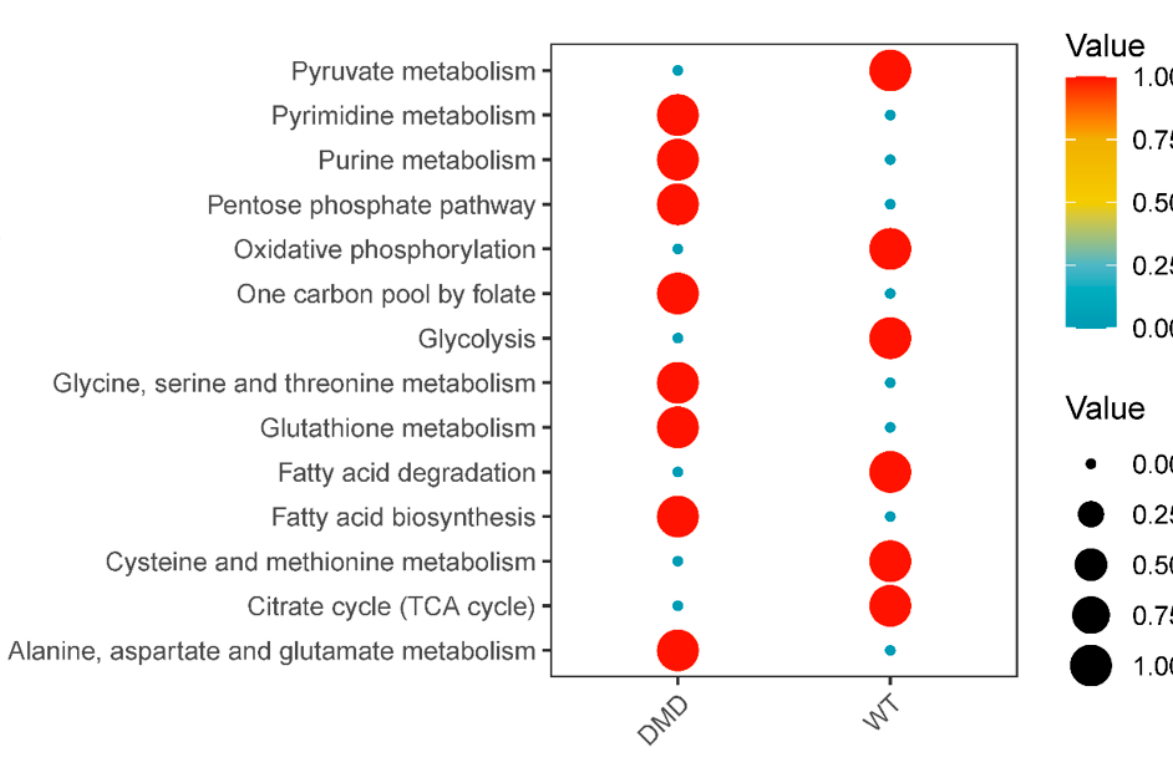
Figure 4. Dot plot illustration of the metabolic pathway analyses performed by “scMetabolism” R package for ECs from DMD mut and WT muscle.